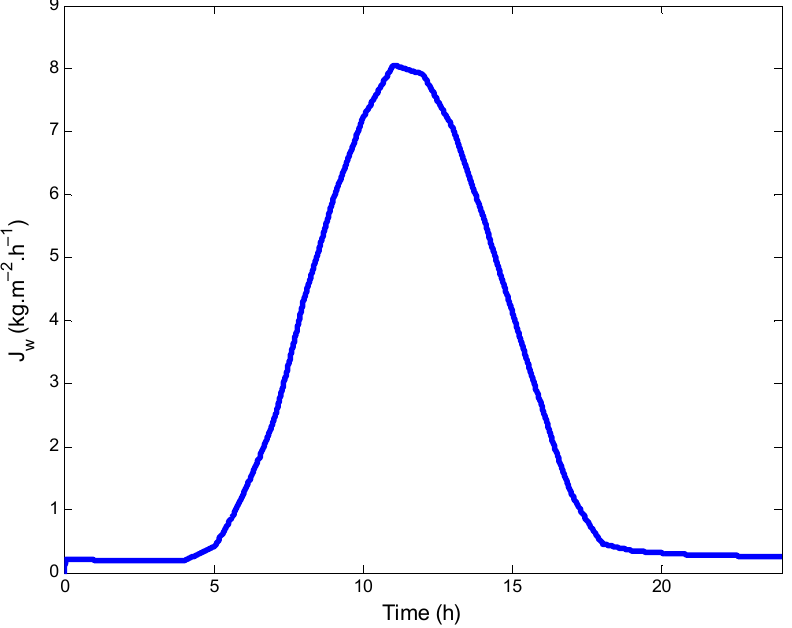
Figure 12. Variation of permeate flux over the local time.